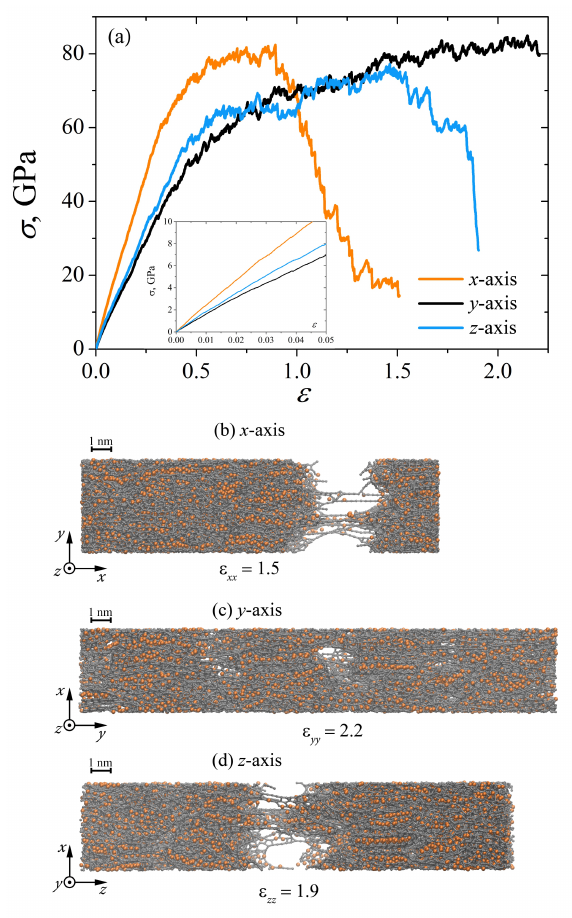
Figure 7. ( a ) Stress–strain curves during uniaxial incremental tension along the x , y and z -axes at strain rate ˙ ε = 5 × 10 − 4 ps − 1 . ( b – d ) The snapshots of Ni/graphene composite during incremental deformation along the x , y and z -axes, respectively. Colors as in Figure